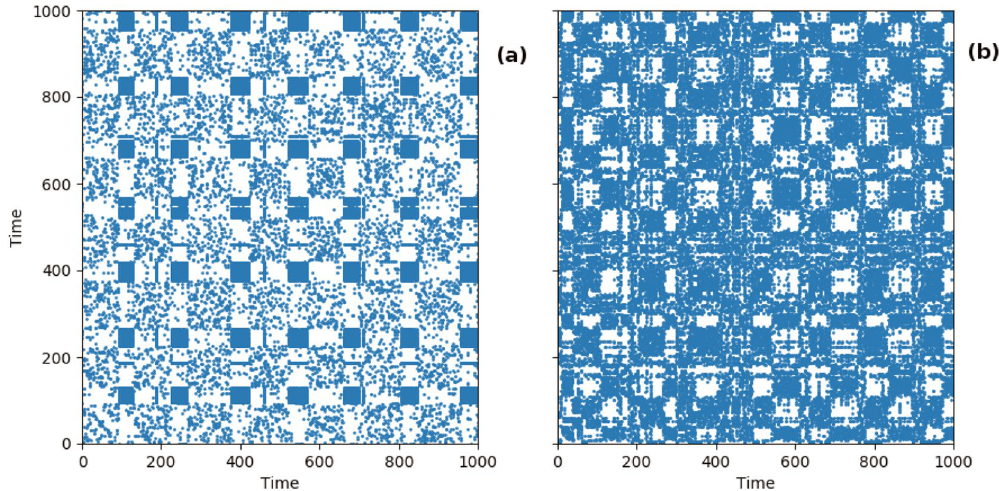
Figure 4. Sample recurrence plots for two individuals. ( a ) Shows the recurrence plot constructed from a non- depressed individual and ( b ) shows one constructed from a depressed individual.